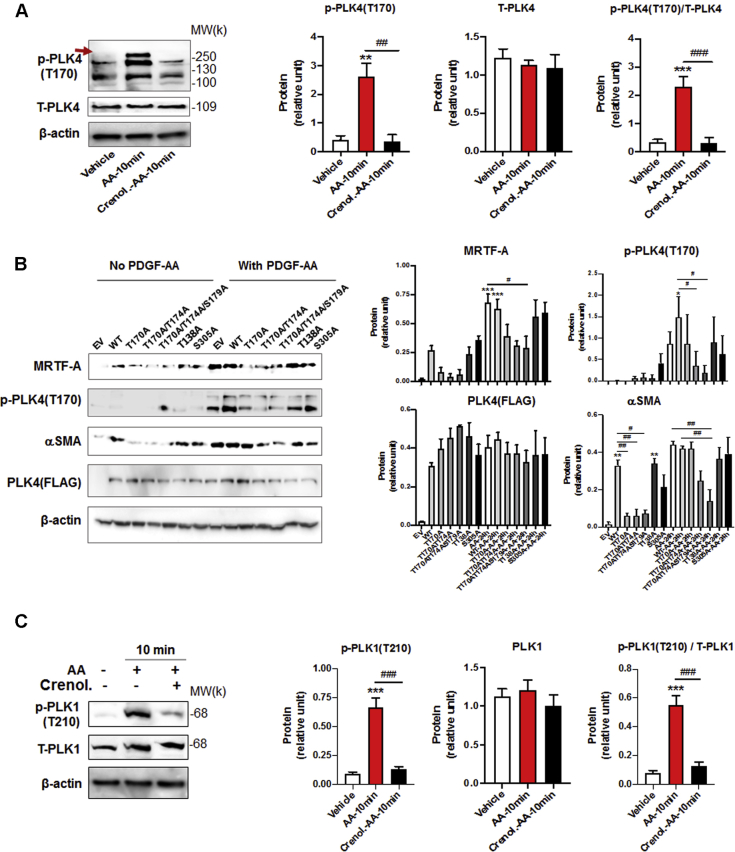
PDGFR Inhibition Blocks PLK4 Phosphorylation(A) Inhibition of PLK4 phosphorylation by the PDGFR-selective inhibitor crenolanib. Rat primary adventitial fibroblasts were cultured, starved, and pretreated with vehicle (DMSO) or crenolanib (1 μmol/l, 30 min), and then stimulated with AA (60 ng/ml) for 10 min before harvest for Western blotting. The arrow points to the band of phospho-PLK4. (B) PLK4 mutation at T170 inhibits PLK4 function. Fibroblast cells (C3H cell line) transduced with lentivirus to express the empty vector control (EV) or PLK4 wild type (WT) or mutants were selected with puromycin, starved overnight and then stimulated with solvent or AA (60 ng/ml). Exogenous PLK4 expression levels were monitored by Western blotting against the FLAG tag. (C) Inhibition of PLK1 phosphorylation by the PDGFR-selective inhibitor crenolanib. Rat primary adventitial fibroblasts were cultured, starved, and pretreated with vehicle (DMSO) or crenolanib (1 μmol/l, 30 min), and then stimulated for 10 min before harvest for Western blotting. Quantification: mean ± SEM, n ≥3 experiments, 1-way ANOVA/Bonferroni test: #p < 0.05; ##p < 0.01; ###p < 0.001. ∗p < 0.05; ∗∗p < 0.01; ∗∗∗p < 0.001 compared with the basal control (the first bar in each plot). Abbreviations as in Figures 1 and 4.